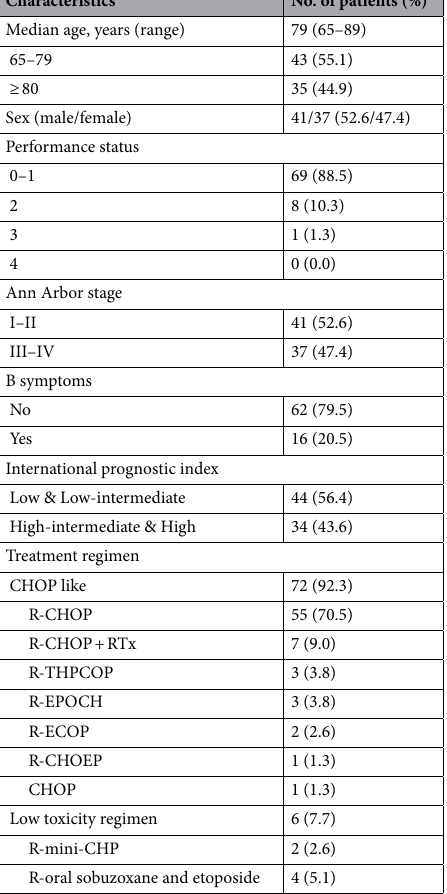
Table 1. Baseline clinical features of 78 DLBCL patients. CHOEP addition of etoposide to CHOP, CHOP cyclophosphamide, doxorubicin, vincristine, prednisolone, mini-CHP subtraction of vincristine from 50% dose CHOP, COP cyclophosphamide, vincristine, prednisolone, DLBCL diffuse large B-cell lymphoma, ECOP addition of etoposide to COP, EPOCH consists of continuously infused etoposide, doxorubicin, cyclophosphamide, vincristine, prednisolone, R rituximab, RTx radiotherapy, THPCOP addition of pirarubicin to